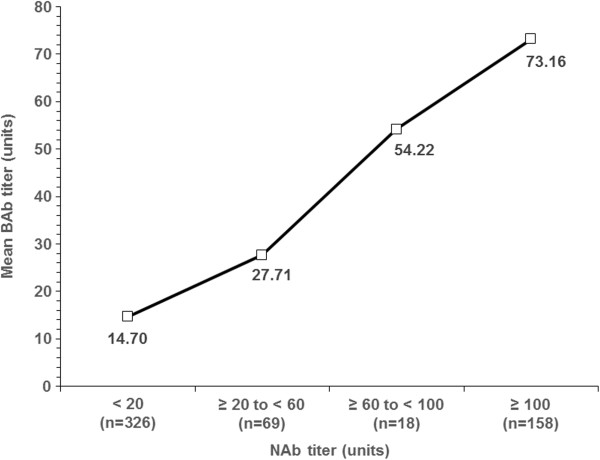
Summary of the relationship between serum binding antibody (BAb) and serum neutralising antibody (NAb). Mean (± standard deviation) BAb titre at various levels of NAb titre. τ = 0 · 54, p < 0.0001 for Kendall’s tau. R2 = 0.5264, p < 0.0001 using standard regression analysis.